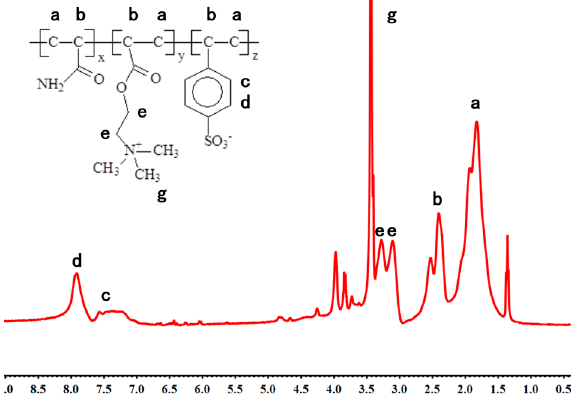
Figure 3. 1 H NMR spectrum of PASD.